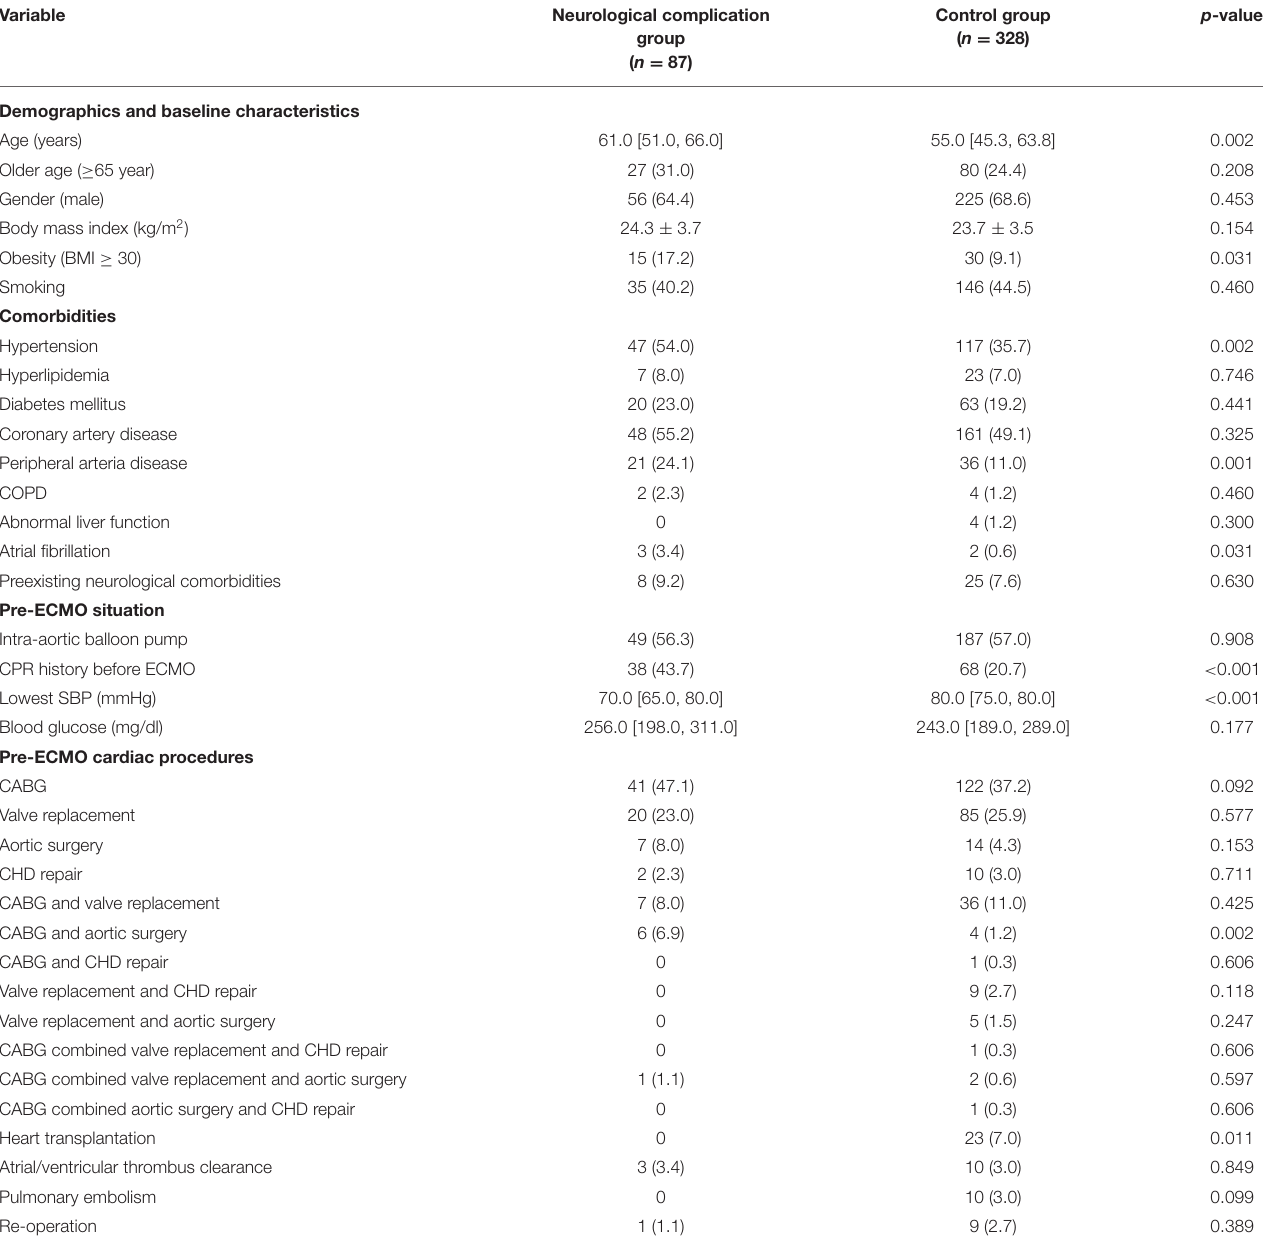
TABLE 1 | Demographics, baseline characteristics, and pre-extracorporeal membrane oxygenation information. Variable Neurological complication